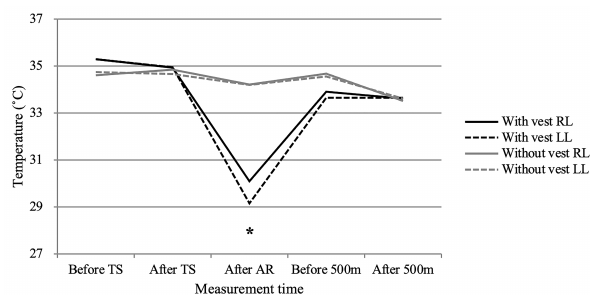
Fig. 3. Skin temperature along the protocol – variation dur- ing the whole protocol in both situation of the study (AR with and without the cooling vest). Grey lines represent the protocol where the kayaker performed the AR with the cooling vest and black lines the AR without wearing it. Continues and dashed lines represent right or left lattisimus dorsi , respectively. The asterisk is indicating that after the AR there is a significant difference ( p < 0.01) in the temperature values between AR conditions. RL, right latissimus dorsi ; LL, left latissimus dorsi .